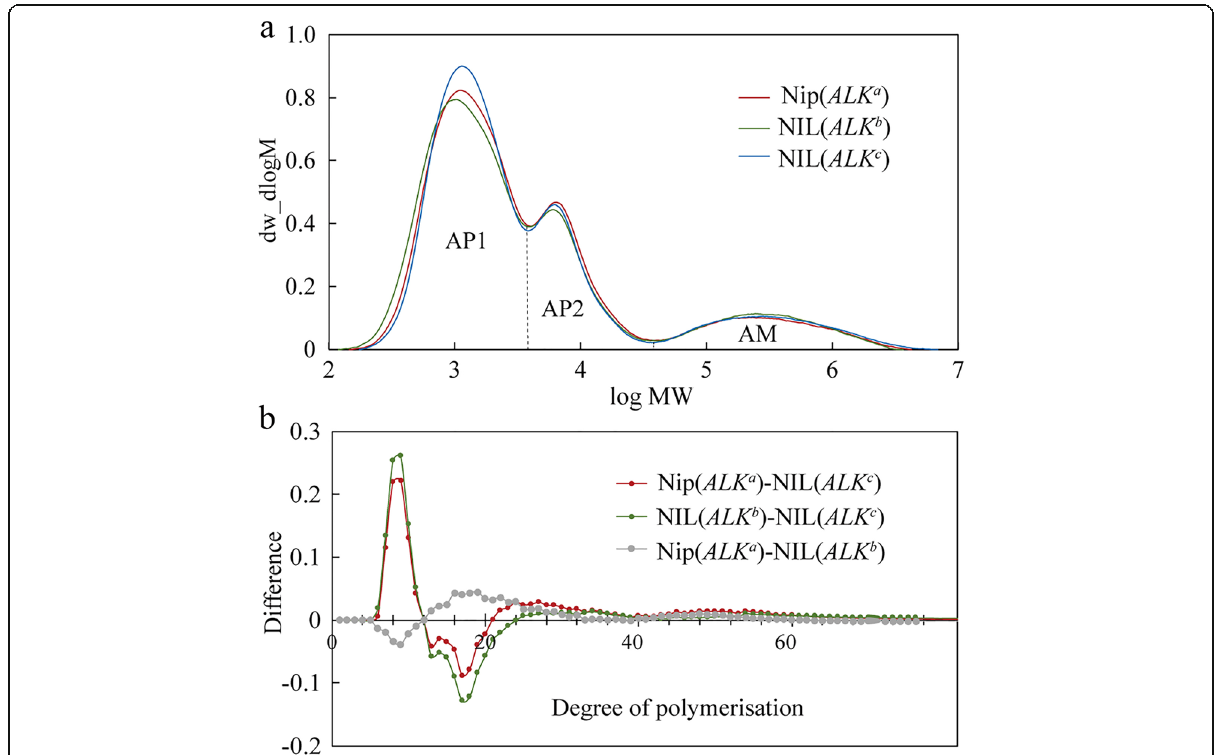
Fig. 5 Comparison of starch fine structures among rice grains from different near-isogenic lines (NILs). a Gel permeation chromatography (GPC) curves of debranched starch from NILs ’ mature seeds. AP1 and AP2 represent the short chain (AP1) and long chain (AP2) fractions of amylopectin, respectively. AM means the amylose fraction. b The difference of degree of polymerization (DP) of debranched starch of different NILs